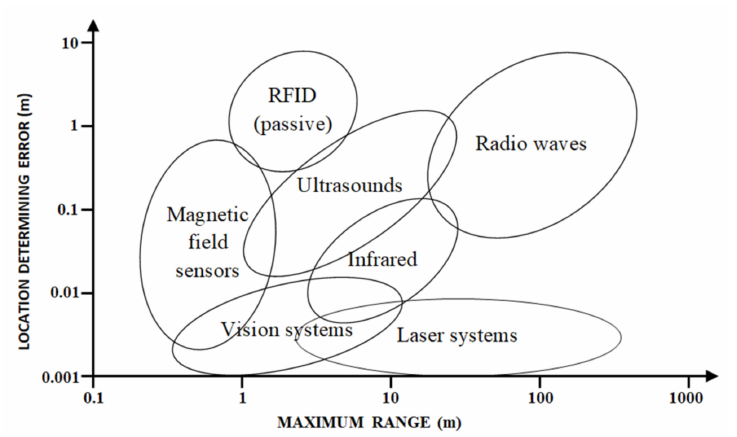
Figure 2. Classification of technologies for the location of indoor objects.